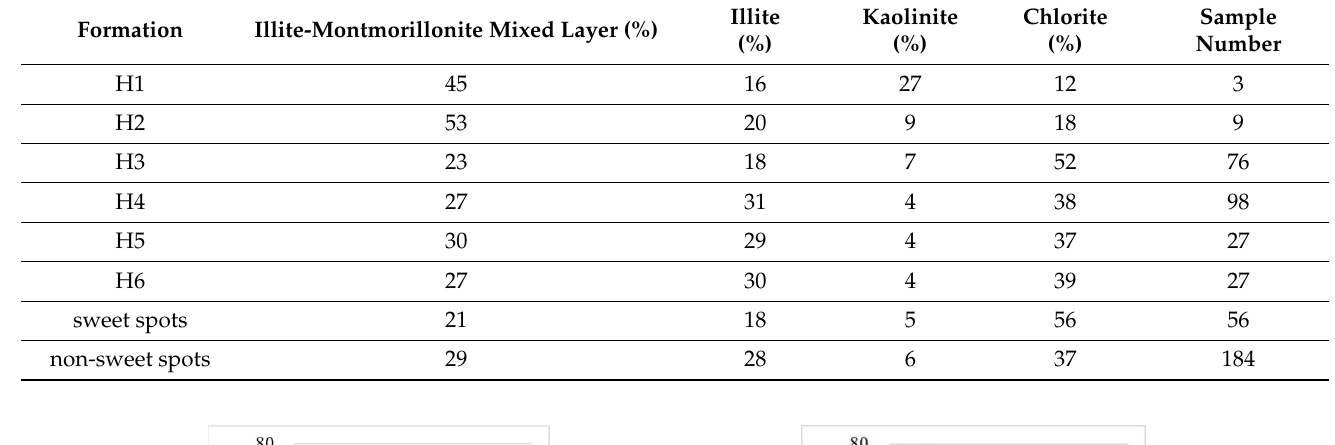
Figure 2. Histogram of petrophysical property distribution in the study area. Table 1. Data of average relative content of clay minerals in the X gas field.